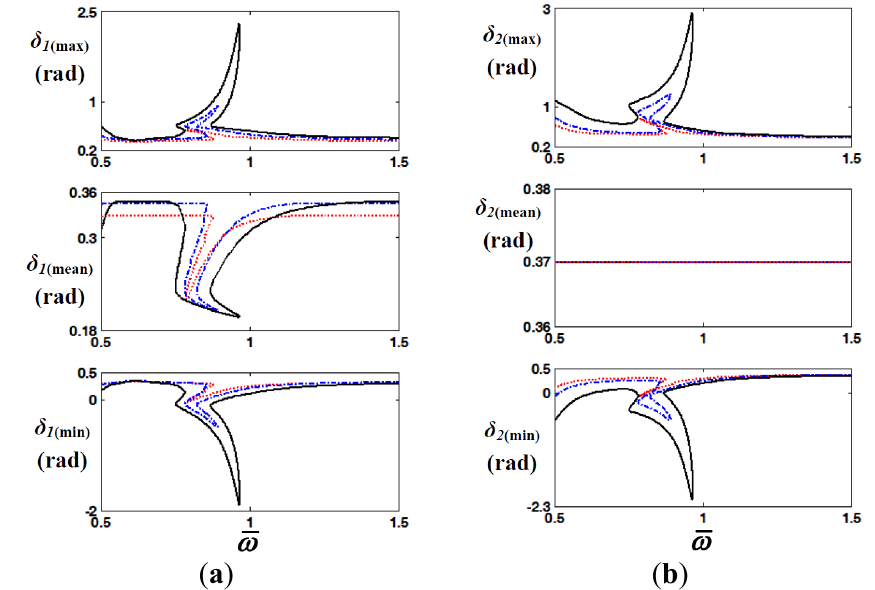
Figure 8. Comparison of the HBM ( N max = 12 and ρ = 1) results along with different excitation conditions in the frequency domain: ( a ) comparison of max, mean, and min values of